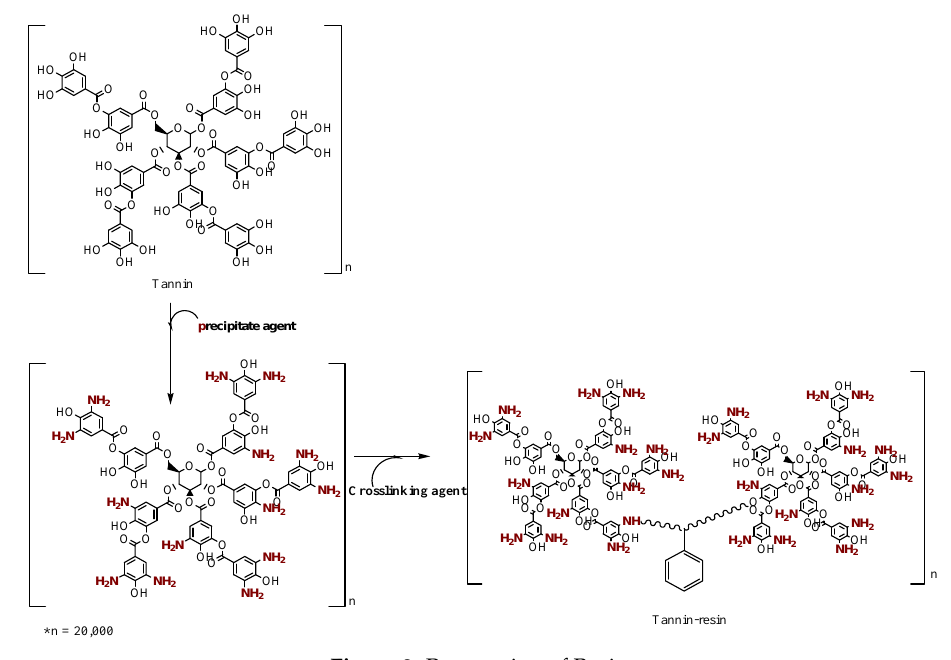
Figure 2. Preparation of Resin.